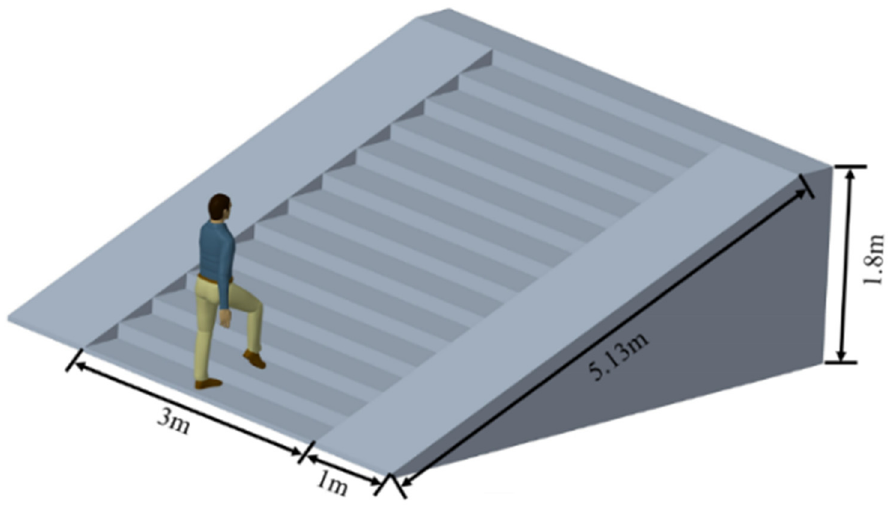
Figure 10. Test site for steps and ramps.